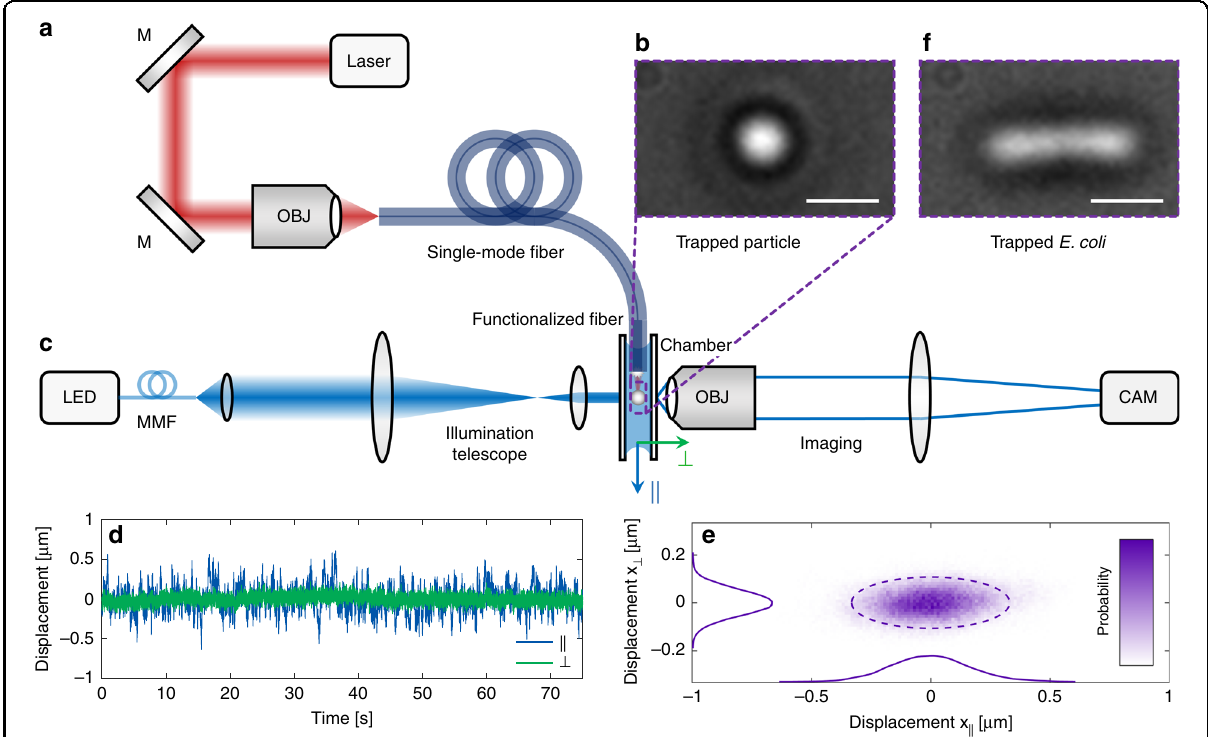
Fig. 4 Optical trapping using a single UNM-enhanced SMF. a Sketch of the trapping setup consisting of a high-power laser ( λ 0 = 660 nm) coupled to an UNM- fi bre sample, ( b ) windowed chamber with micro-objects immersed in water, and ( c ) Koehler illumination (left, a wavelength of 455 nm) and imaging system (right) used to record the motion of the trapped object. The top right images show micrograph examples of ( b ) a trapped 2 µm silica sphere and ( f ) a trapped Escherichia coli ( E. coli ) bacterium (scale bars: 2 µm). d Examples of spatial dynamic displacements for a trapped silica bead along with the transverse (green) and longitudinal (blue) directions for a trapping time of >1 min. e Corresponding 2D representation of the probability with projections on the respective axes. The dashed ellipse depicts the 2 σ -environment containing 95% of the